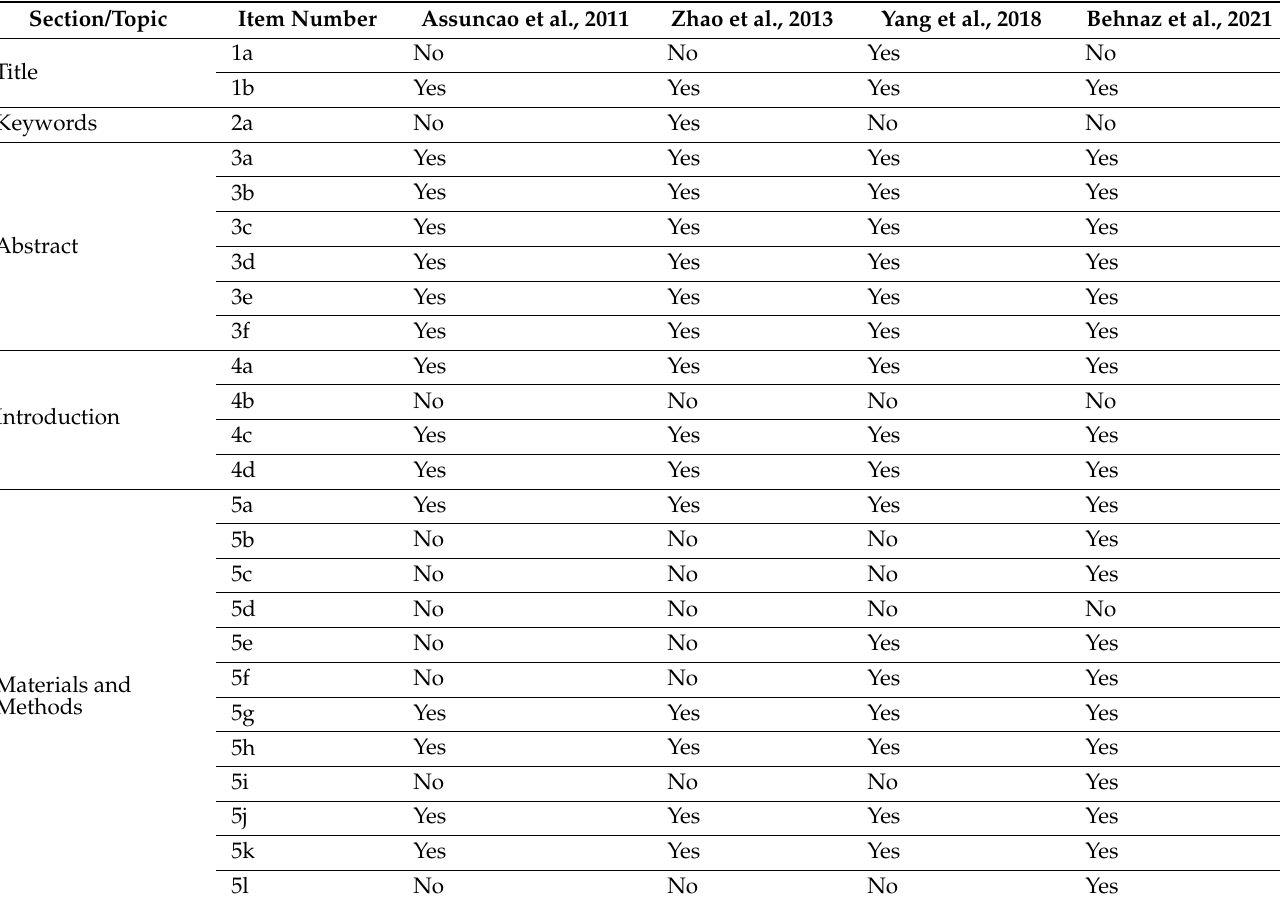
Table 4. Results of the quality assessment of the included anmal studies. The details of each study item assessed is provided in the additional supplementary